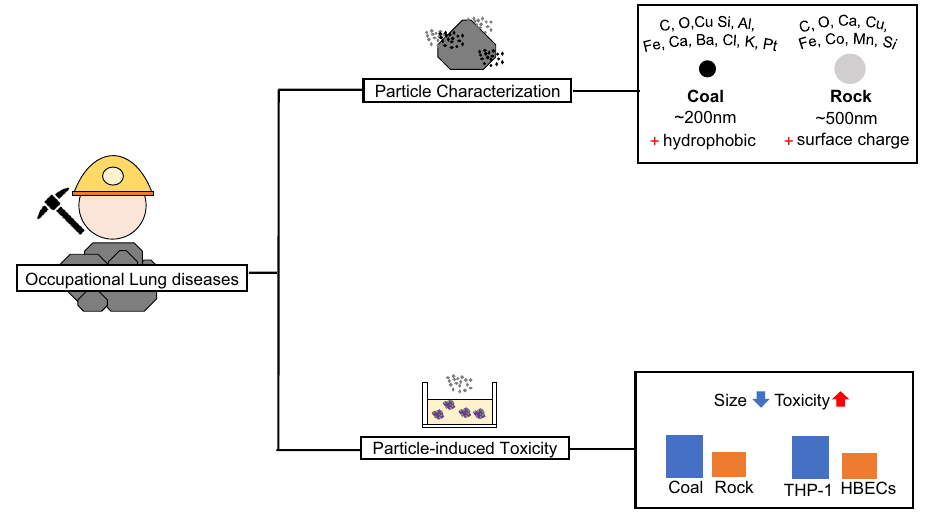
Figure 9. Summary for present study: the dependence of particle size on cell toxicity for modern mining